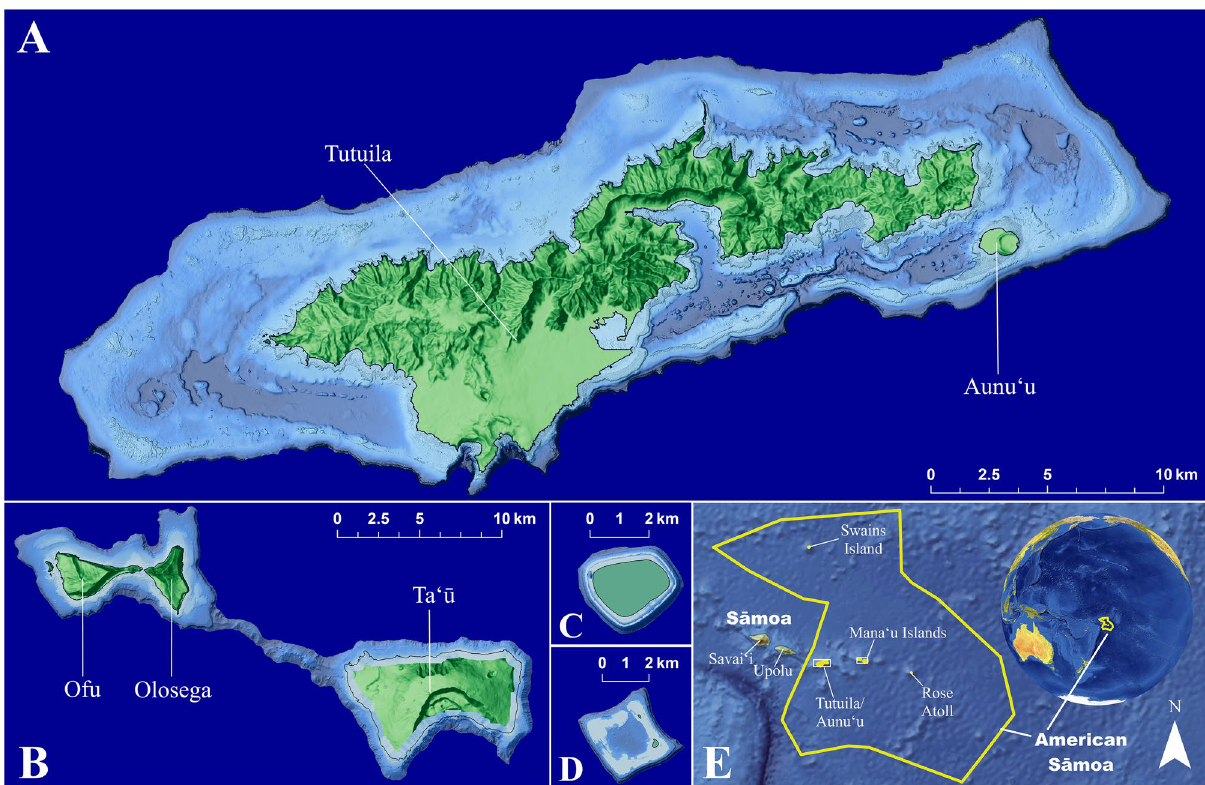
Figure 1. Map of American Sāmoa showing the islands and bathymetry of MCEs on Tutuila and Aunu ʻ u ( A ), Manu ʻ a Islands of Ofu, Olosega, and Ta ʻ ū ( B ), Swains Island ( C ), Rose Atoll ( D ), and the location of all islands with the exclusive economic zone ( E ). Map created with ArcGIS Pro 2.6.3 (https:// www. esri. com/ en- us/ arcgis/ produ cts/ arcgis- pro/ overv